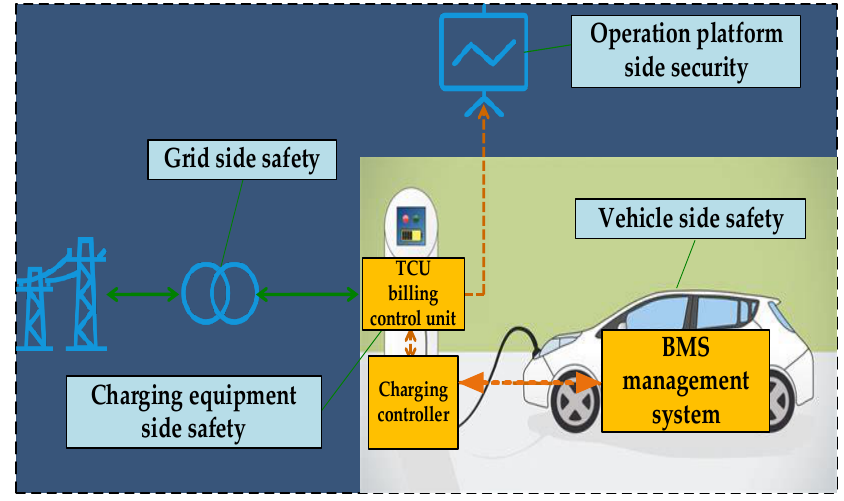
Figure 2. Charging network technology classification (TCU: Terminal Control Unit).